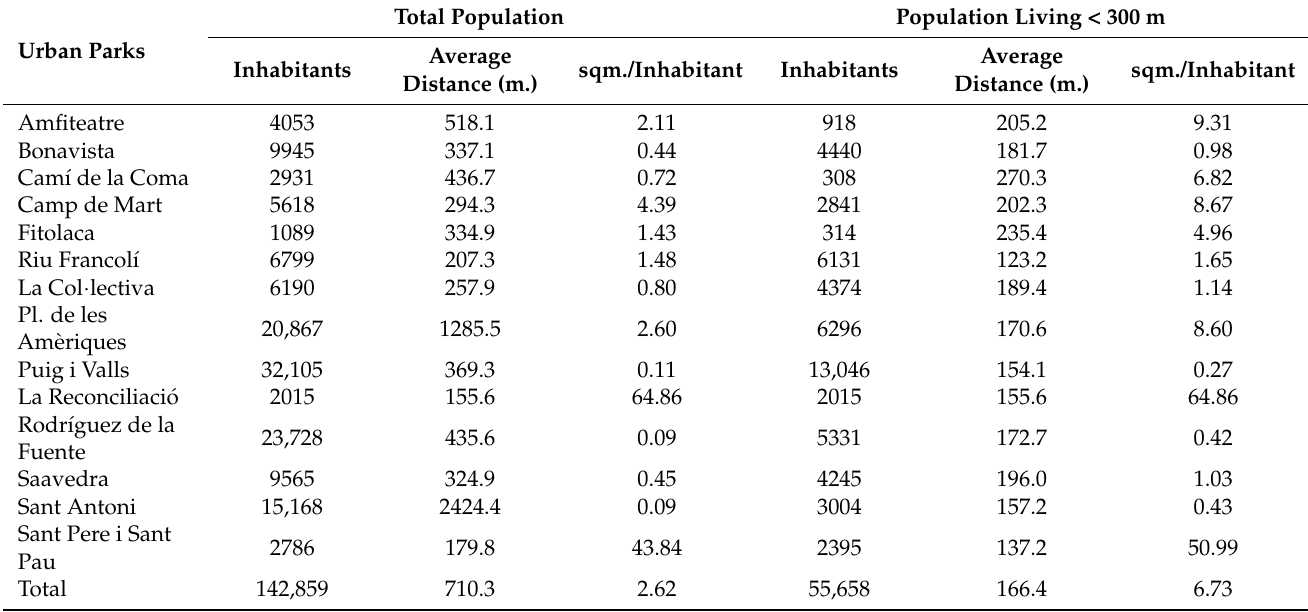
Table 2. Average surface area available per inhabitant and average distance to the nearest urban park.